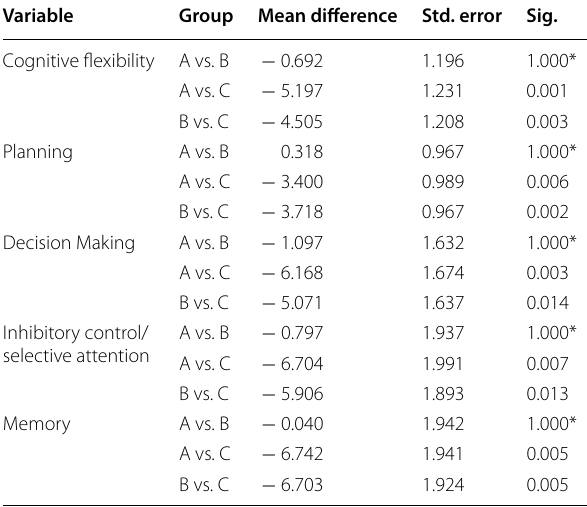
*The mean difference is not significant ( p > 0.05)